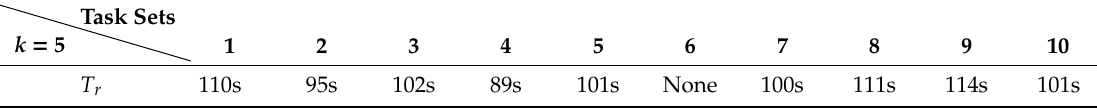
Table 2. The total time required to obtain service results when k =